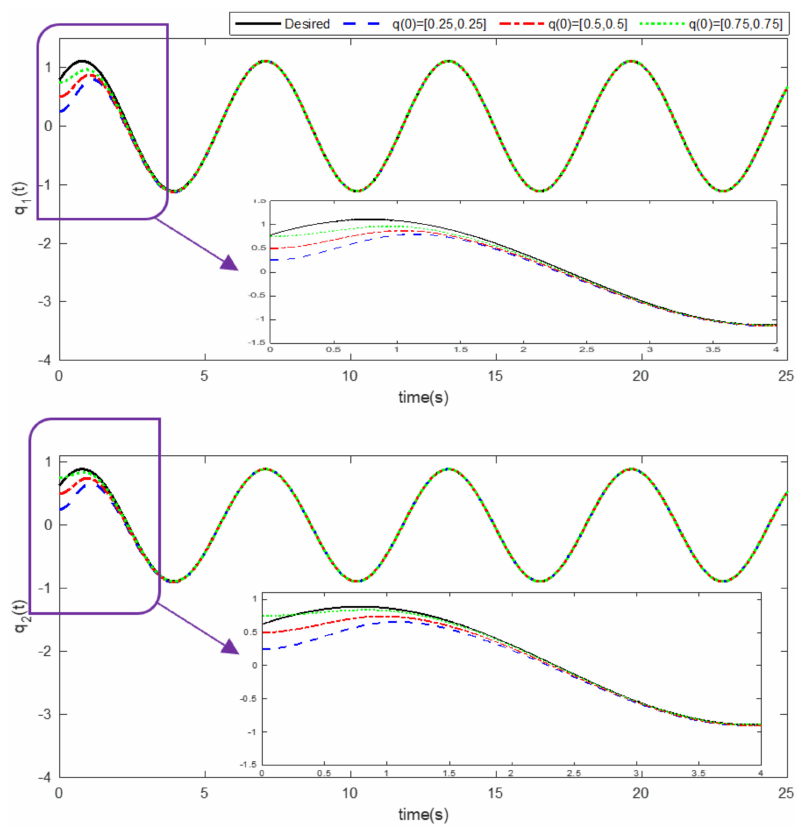
Figure 9. Desired tracking of the exoskeleton robot system under different initial conditions. (Example 2).